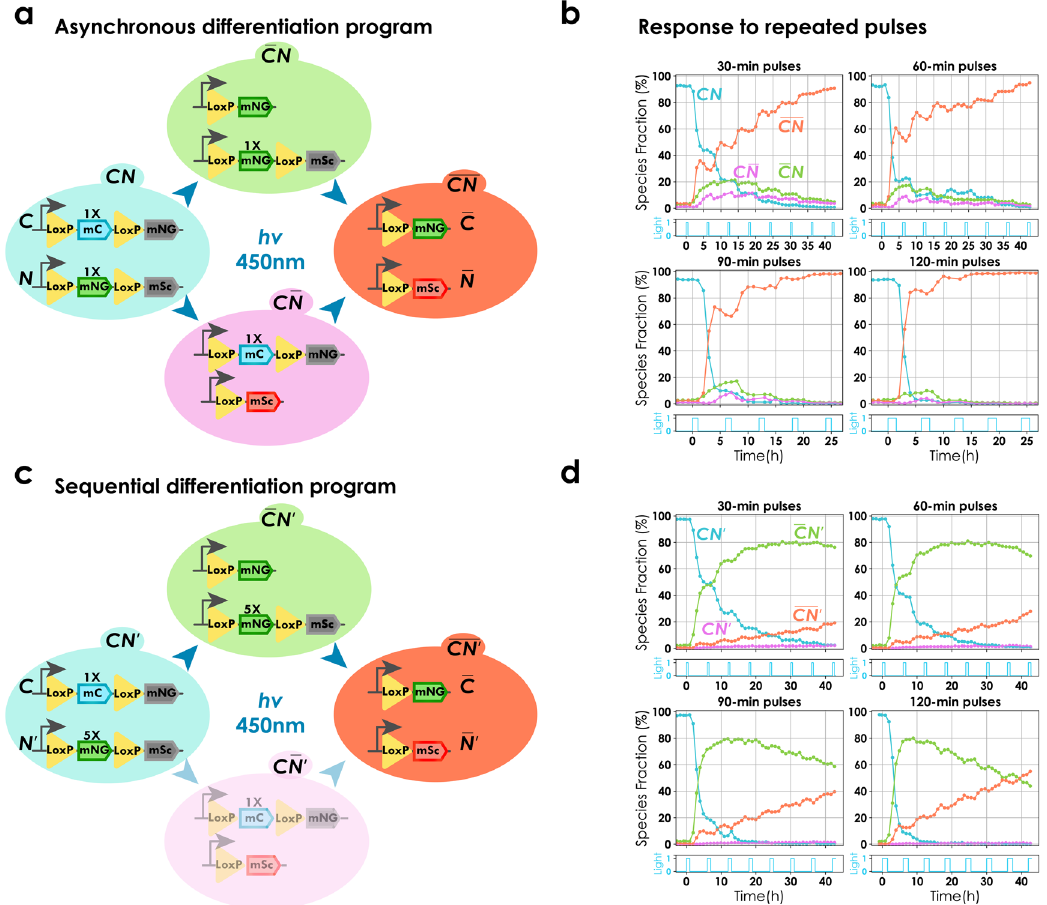
Fig. 5 Engineering differentiation programmes for complex consortia with multiple subpopulations. a Asynchronous differentiation programme. Two recombination cassettes (C and N) were introduced along with the differentiation system in the same strain. Both cassettes consisted of to-be-excised region of equal lengths (1× of the original system (Fig. 1a). All four possible cell types are shown (neither cassettes recombined (CN), single cassette recombined (CN & CN), and both cassettes recombined (CN)). Circuits shown in the panel are representational (Supplementary Fig. 22). b Response to repeated pulses of different lengths. Four cultures were induced with repeated light pulses of different durations, 6 h apart. Each subplot represents data from a single experiment with unique pulse duration given by cyan subplots (clockwise from top right, 30, 60, 90, and 120 min, respectively). Solid lines show dynamics of prevalence of each subpopulation (blue, purple, red, and orange for CN, CN, CN, and CN, respectively). Circles indicate individual time points. Prevalence of each population was calculated using thresholds on mNeonGreen, mScarlet-I, and mCerulean fl uorescence (Supplementary Note 7 and Supplementary Fig. 23). All four subpopulations could be observed. We note that the small decrease in the fraction of CN cells just after differentiation and a corresponding increase in CN is an artefact of the threshold-based quanti fi cation that is limited by the dilution of mNeonGreen. c Sequential differentiation programme. Two recombination cassettes were introduced along with the differentiation system in the same strain. Relative length of the to- be-excised region of one cassette (N 0 ) was 5× longer than the other (C). All four possible cell types are shown. Notations resemble a . Due to increase in the length of to-be-excised region, the differentiation rate of N 0 was signi fi cantly slower than C leading to inappreciable prevalence of CN 0 (faded cell type) (Supplementary Fig. 22). d Response to repeated pulses of different lengths. Four cultures were induced with repeated light pulses of different durations, 6 h apart. Each subplot represents data from a single experiment with unique pulse duration (clockwise from top right, 30, 60, 90, and 120 min, respectively). Data are represented as in ( b ). Three subpopulations could be